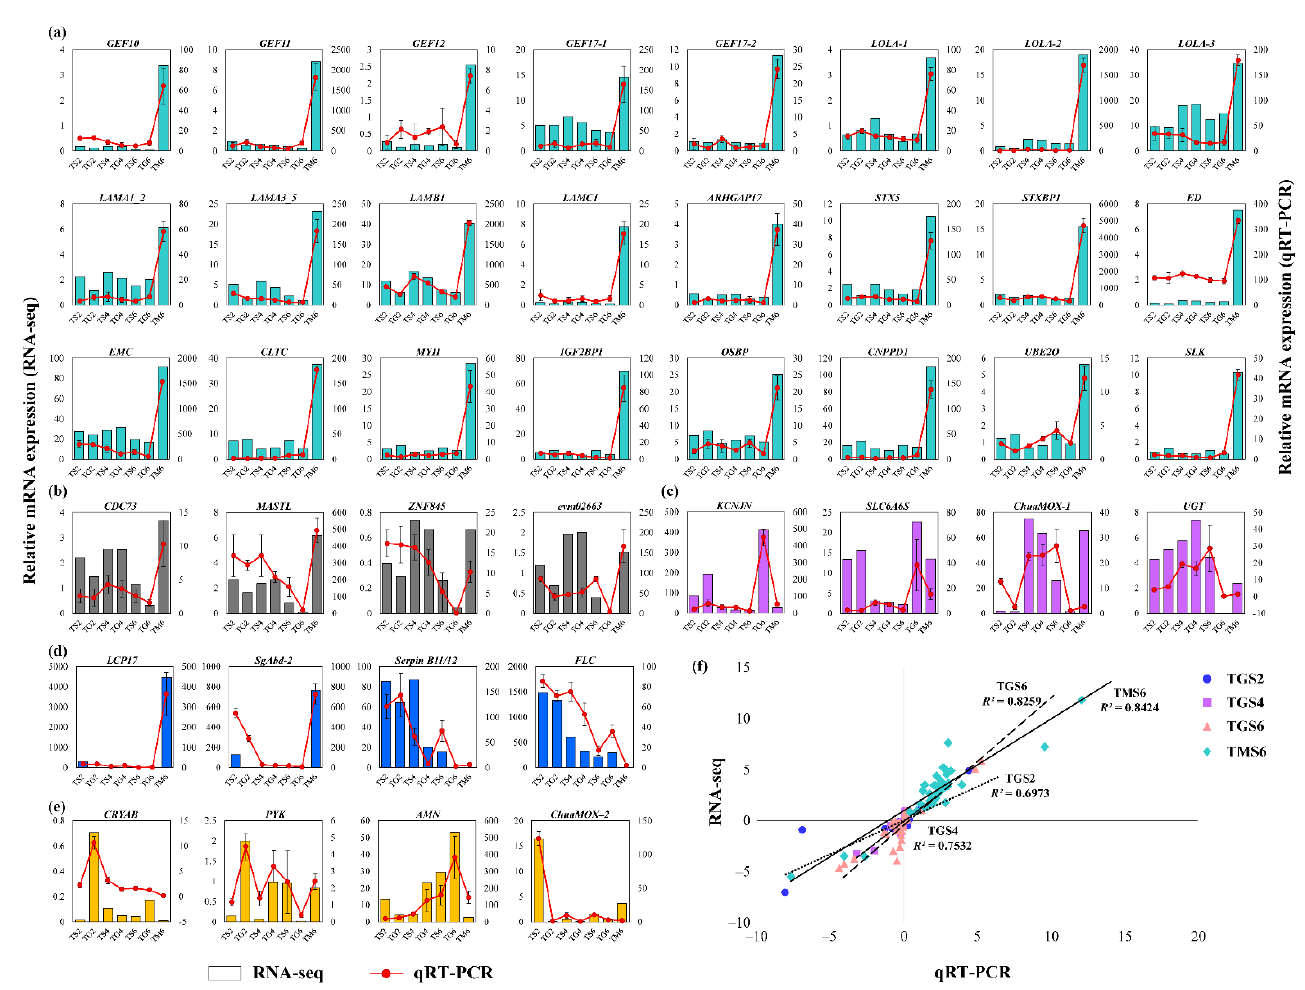
Figure 7. Validation of the selected genes in T. xiaojinensis from RNA-seq by qRT-PCR. RNA-seq and qRT-PCR results of hub genes from ( a ) Turquoise and ( b ) DarkGrey modules, DEGs from ( c ) TGS6 and ( d ) TMS6, as well as ( e ) four randomly selected genes. ( f ) Comparison of the log 2 of gene expression ratios between RNA-seq data and qRT-PCR results. Cycle, square, triangle, and rhombus represent the results TGS2, TGS4, TGS6, and TMS6, respectively.